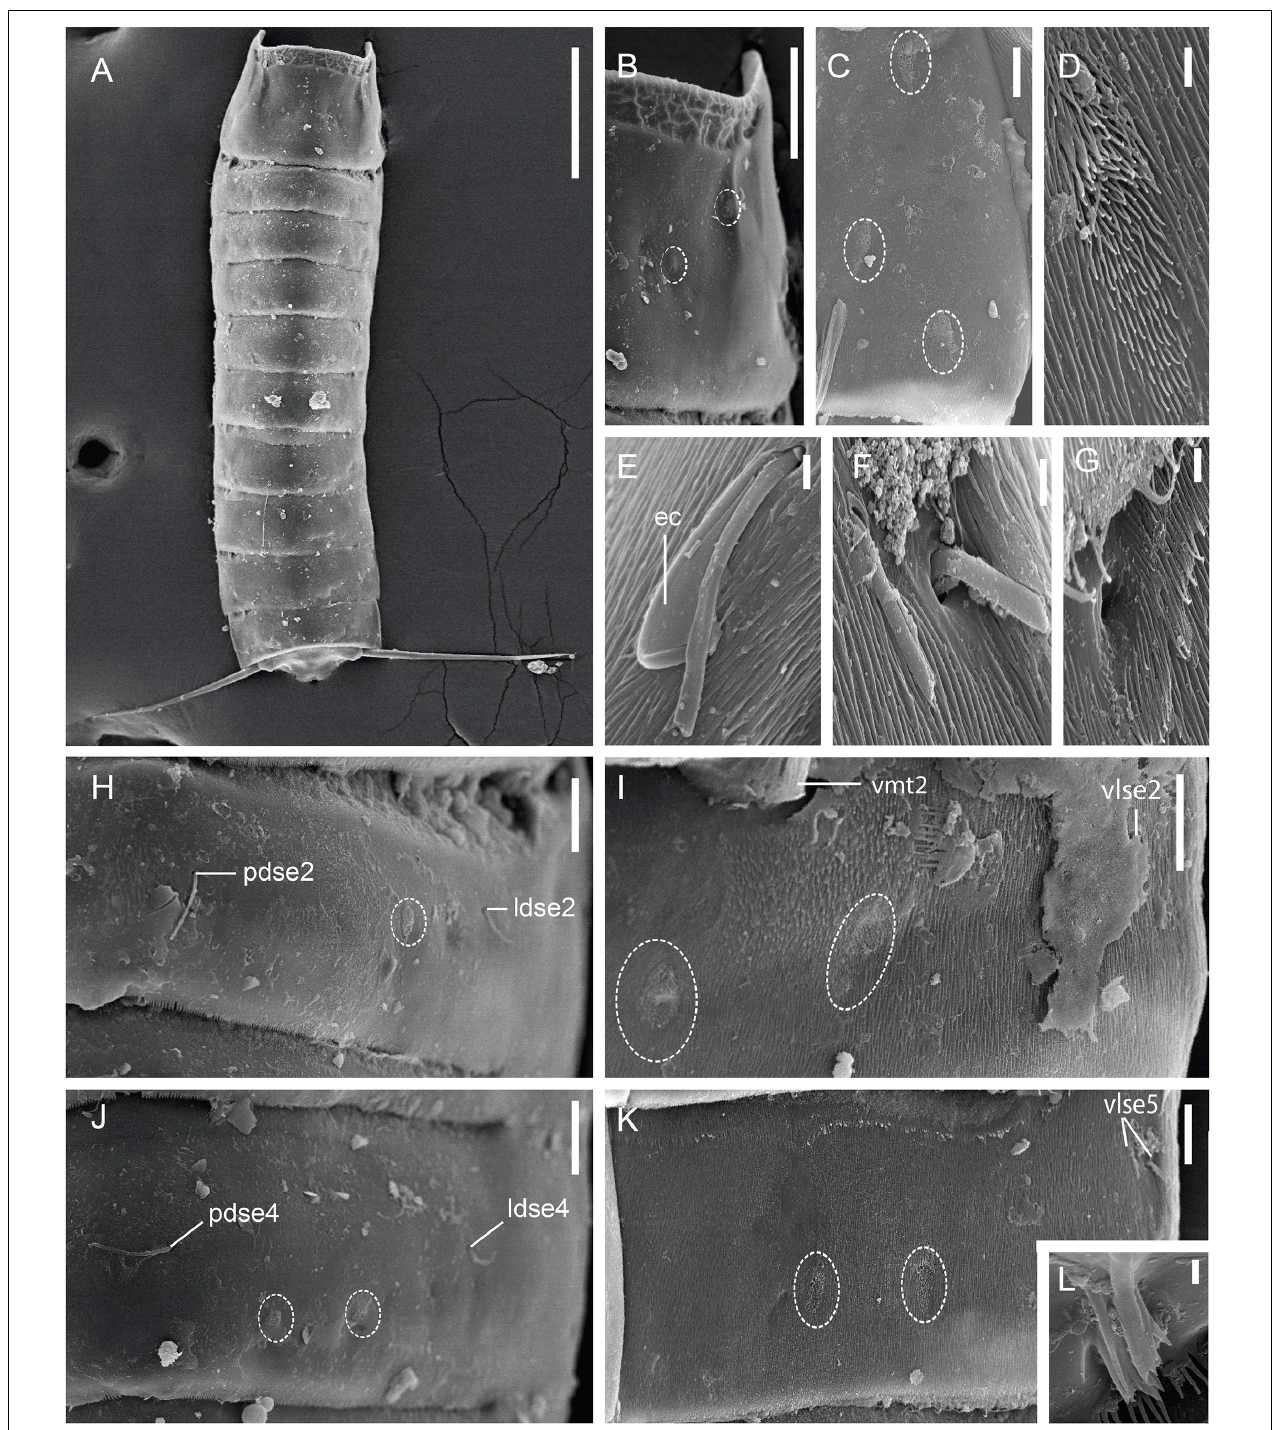
FIGURE 4 | Scanning electron micrographs showing trunk overview and details in the main trunk cuticular appendages of a male of Fujuriphyes dagon sp. nov. (A) Dorsal overview of trunk; (B) middorsal to subdorsal view on left half of tergal plate of segment 1; (C) left episternal plate of segment 1; (D) ventromedial sensory spot of segment 5; (E) lateroventral seta of segment 10; (F) ventrolateral setae of segment 5; (G) ventral cuticular ridge and associated glandular cell outlet of segment 6; (H) middorsal to laterodorsal view on left half of tergal plate of segment 2; (I) left sternal plate of segment 2; (J) middorsal to laterodorsal view on left half of tergal plate of segment 4; (K) left sternal plate of segment 5; (L) laterodorsal type 3 sensory spot of segment 11. Scale bars: (A): 300 µ m; (B): 30 µ m; (C,E,H–L) : 10 µ m; (D,F,G): 1 µ m. Abbreviations: ec, epibiontic Ciliophora; ldse, laterodorsal seta; pdse, paradorsal seta; vlse, ventrolateral seta; vmt, ventromedial tube; numbers after abbreviations indicate corresponding segment; sensory spots are marked as dashed